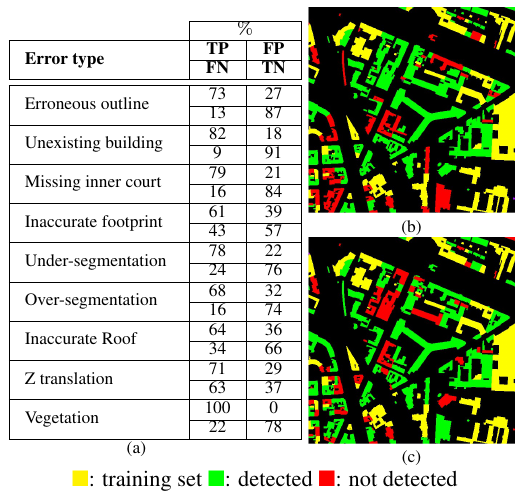
Figure 6: (a) Confusion matrix; (b) Results for the proposed GT overview; (c) Results for the erroneous outline